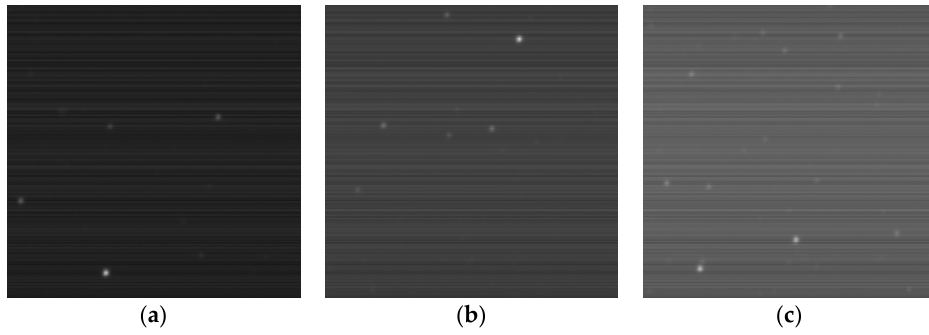
Figure 6. The images obtained before the NUC by superimposing various influence factors and a steady ‐ mode ICS equivalent output at 1000, 3000 and 5000. ( a ) ICS ‐ 1000; ( b ) ICS ‐ 3000; ( c ) ICS ‐ 5000.